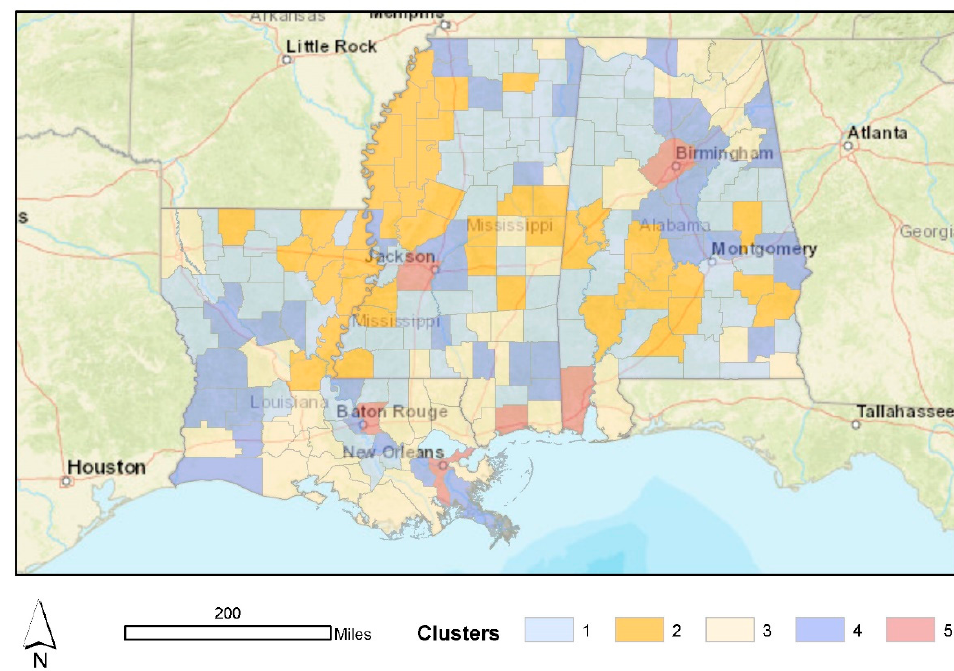
Figure 5. Clusters of breastfeeding initiation and risk. Table 1. Descriptive statistics for key indicators. Table 2. Cluster attributes for breastfeeding initiation and composite